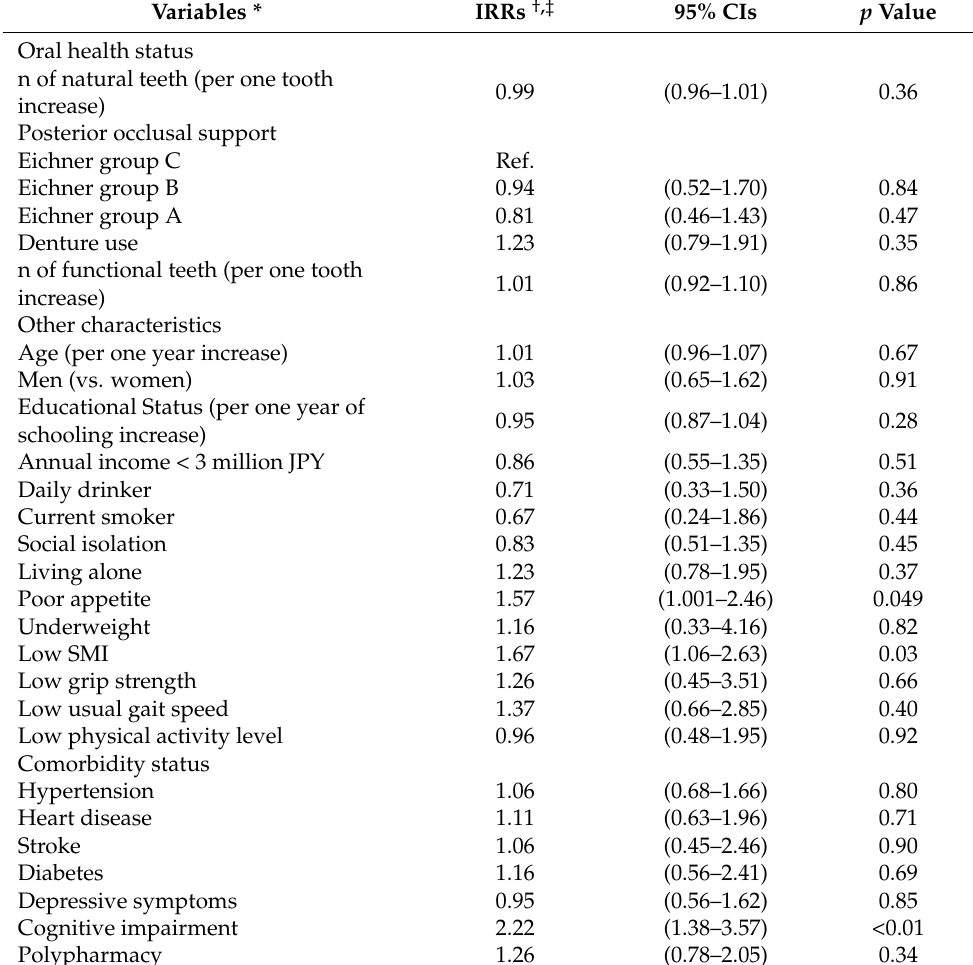
Table 2. Tongue pressure decline in relation to study participants’ baseline